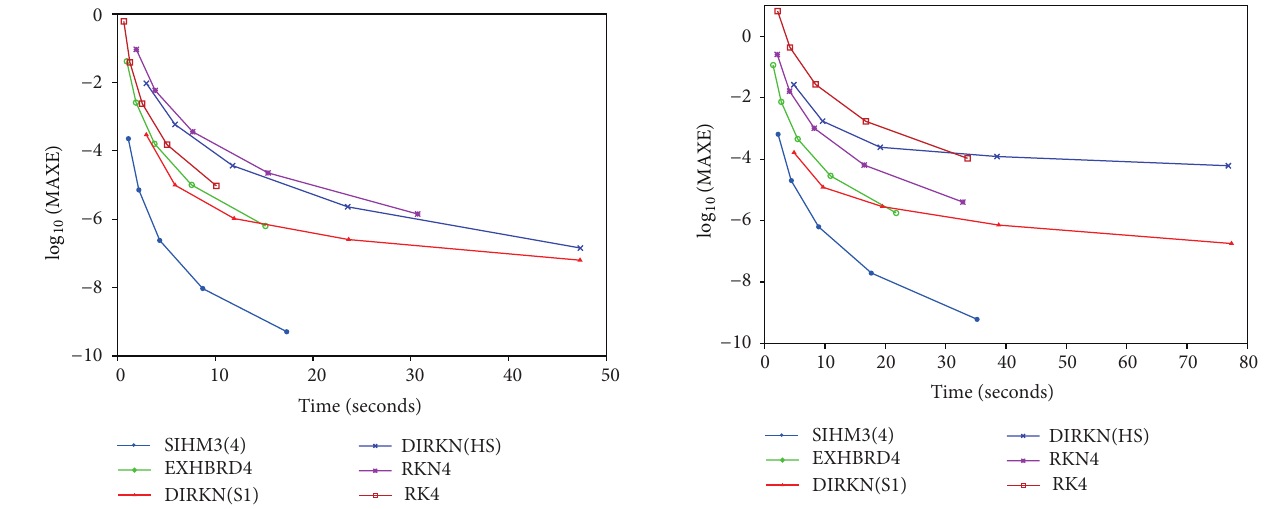
Figure 5: The efficiency curves for SIHM3 (4) method for Inhomo- geneous system with ℎ = 0.125/2 𝑖 , 𝑖 = 1,...,5 .